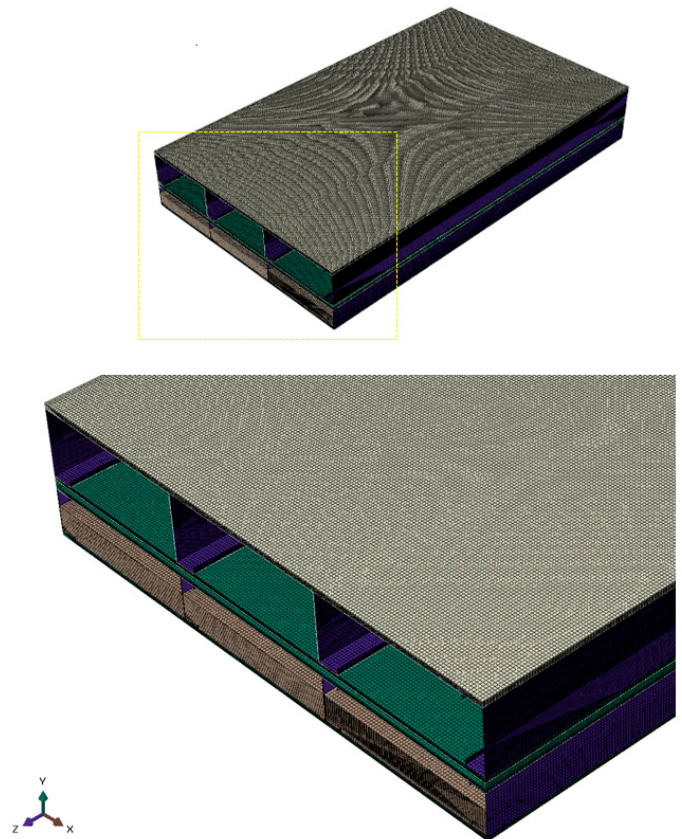
Figure 3. FEM of M_SP_90RW floor system.